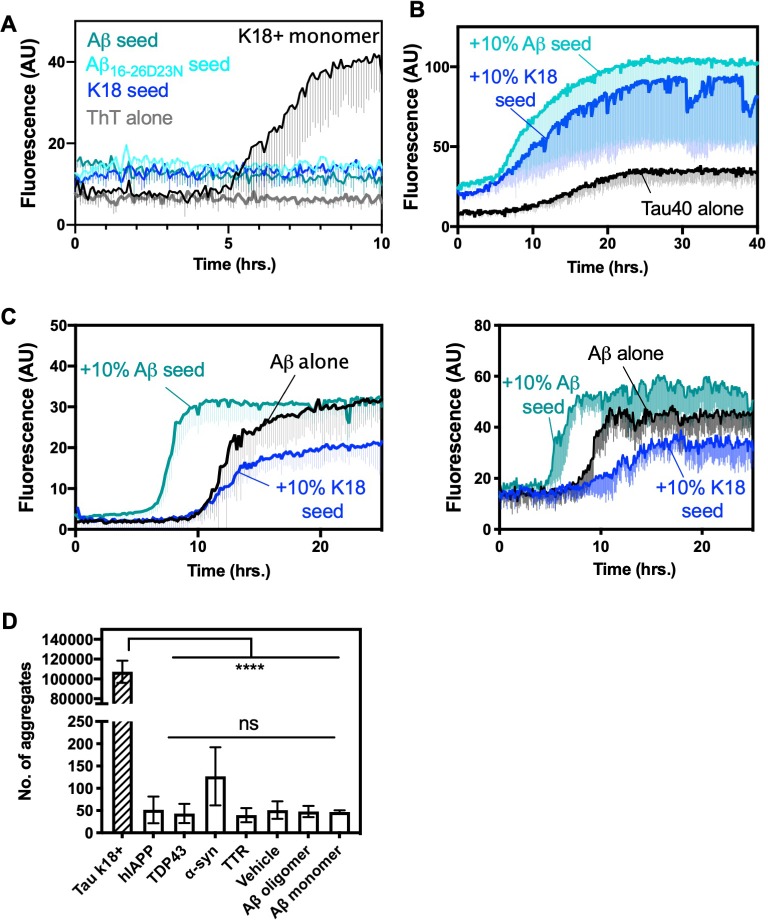
Extended ThT and seeding data.(A) Extended ThT data of Tau seeding experiment. K18+ and Aβ1–42 seeds have some baseline ThT signal (B) 20 μM tau40 was seeded with 10% monomer equivalent of pre-formed fibrils of Aβ1–42 or tau-K18 under shaking conditions at 700 RPM at 37°C in buffer containing 0.5 mg/ml heparin. Fibril formation was monitored using ThT fluorescence. Aβ1–42 or tau-K18 seeds showed reduced lag times (9.4 and 10.2 hr, respectively) than unseeded tau40 (14.0 hr). Error bars show the standard deviation of the average of three technical replicates. T1/2 lag times were calculated using a four-parameter non-linear fit. (C) 10 μM Aβ1–42 was seeded with 10% monomer equivalent of pre-formed seed of Aβ1–42 or K18, under quiescent conditions at 37°C. Fibril formation was monitored using ThT fluorescence. Lines show average of three technical replicates. Left panel was performed in polystyrene plates, right panel was performed in polypropylene plates. (D) Tau-K18+ versus amyloid fibrils of other proteins, and non-fibrillar Aβ efficiency of seeding the HEK293 biosensor that stably expresses K18 yellow fluorescent protein (YFP) fusion. The cells were seeded with 250 nM final concentration of protein. Bars represent mean with individual technical replicates, error bars display one standard deviation (n = 3; ns = not significant; ****, p<0.0001 using an ordinary one-way ANOVA- Tukey’s relative to leftmost column or against all columns excluding leftmost, as indicated). Amyloid fibrils were confirmed by endpoint ThT or Electron Microscopy. Non-fibrillar Aβ was used fresh (monomeric) or incubated for 12 hr 37°C (oligomer).